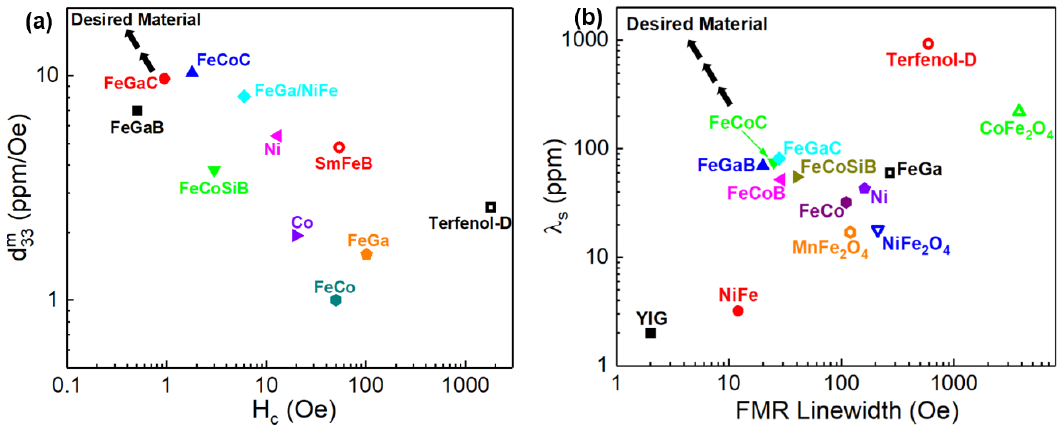
Figure 21. Magnetostrictive materials in summary of ( a ) maximum piezomagnetic coefficient d 33,m vs coercive field H c ( b ) saturation magnetostriction λ s vs FMR linewidth.